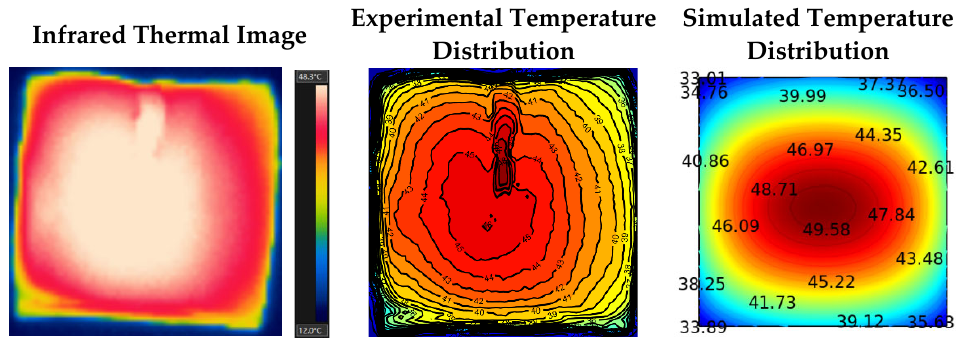
Figure 5. Temperature distribution on the cross-sectional (the zx -section at the center) surface of potato sample from simulated and experimental results.